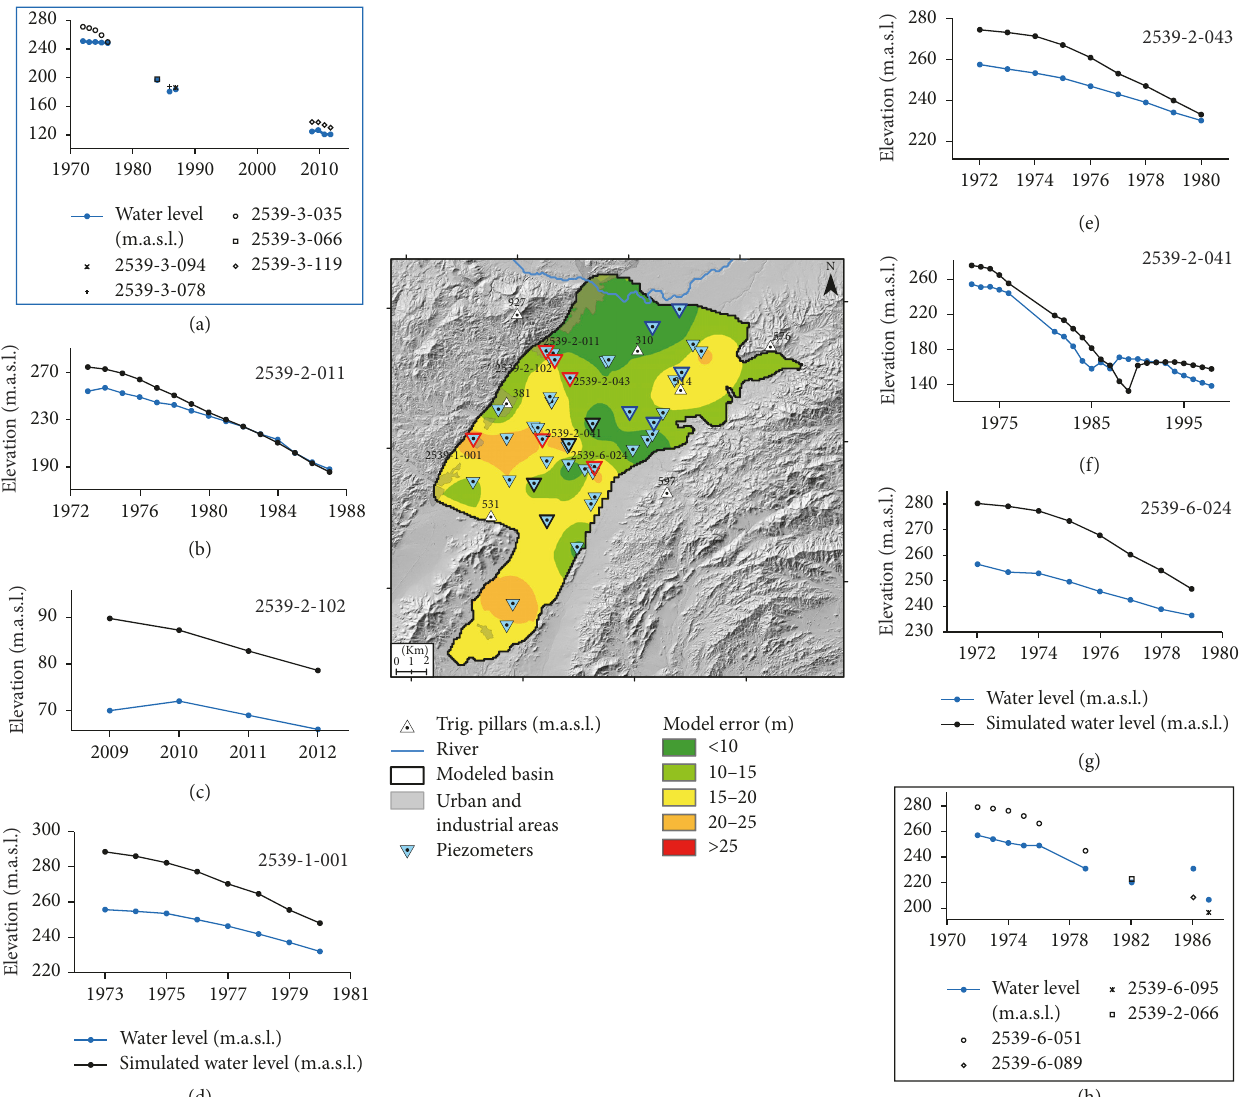
Figure 8: Groundwater model results and spatial error. Central map represents the spatial distribution of model error using average error of each piezometer. Results and observations from piezometers outlined in blue are represented in graphic (a). Graphic (h) represents piezometers outlined in black. Graphics (b) to (g) show piezometers outlined in red